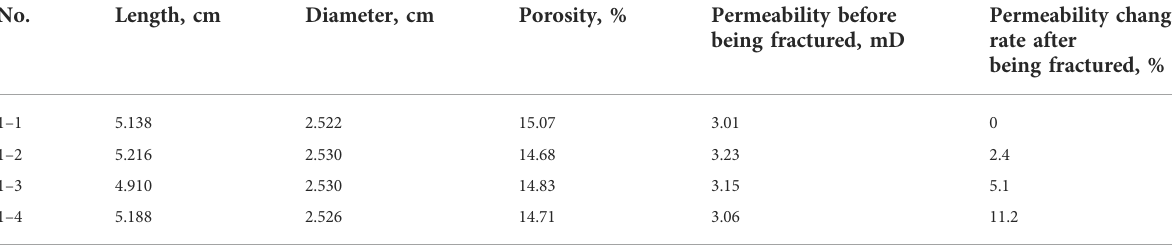
TABLE 4 Properties of cores before and after being